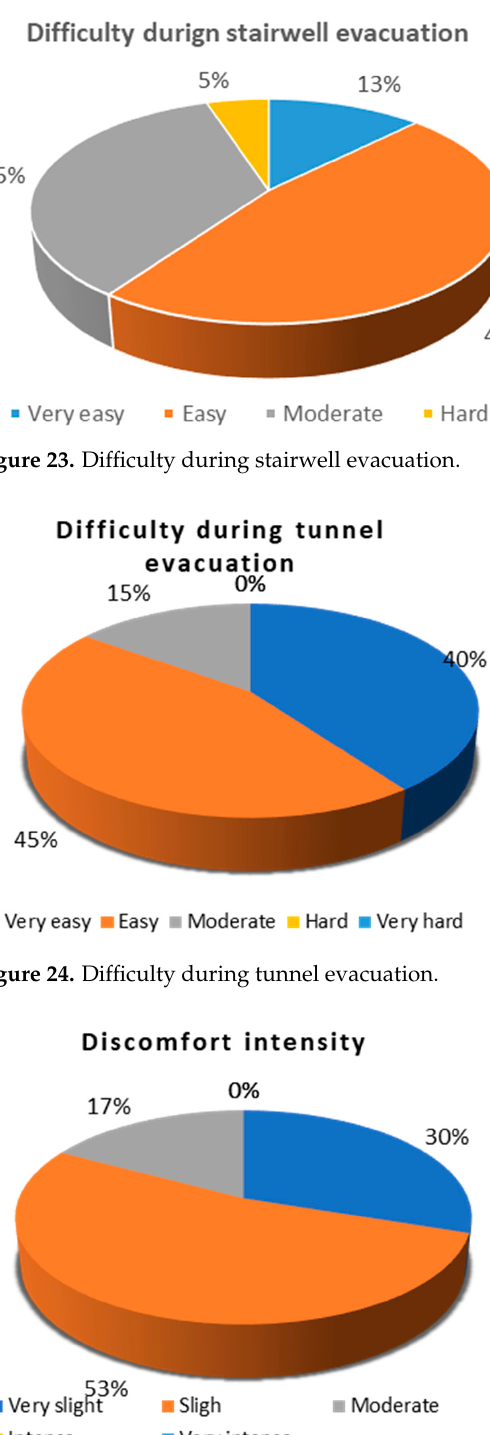
Figure 26. Visibility during evacuation under smoke-filled environment.